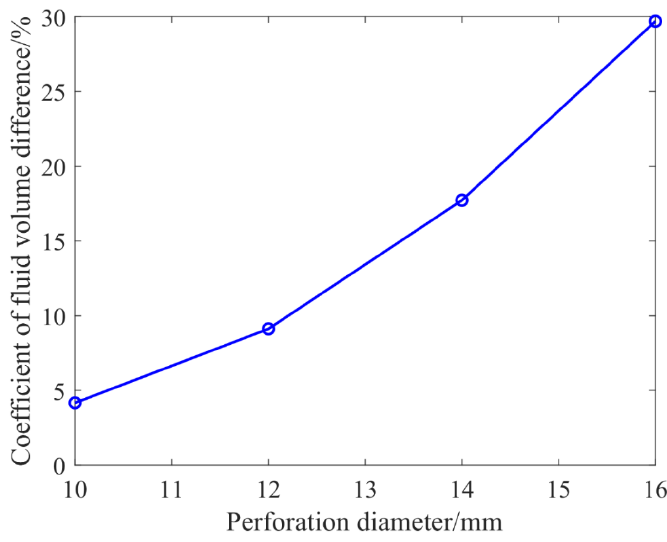
Figure 11. Variation coefficients of fluid allocations at different perforation diameters.